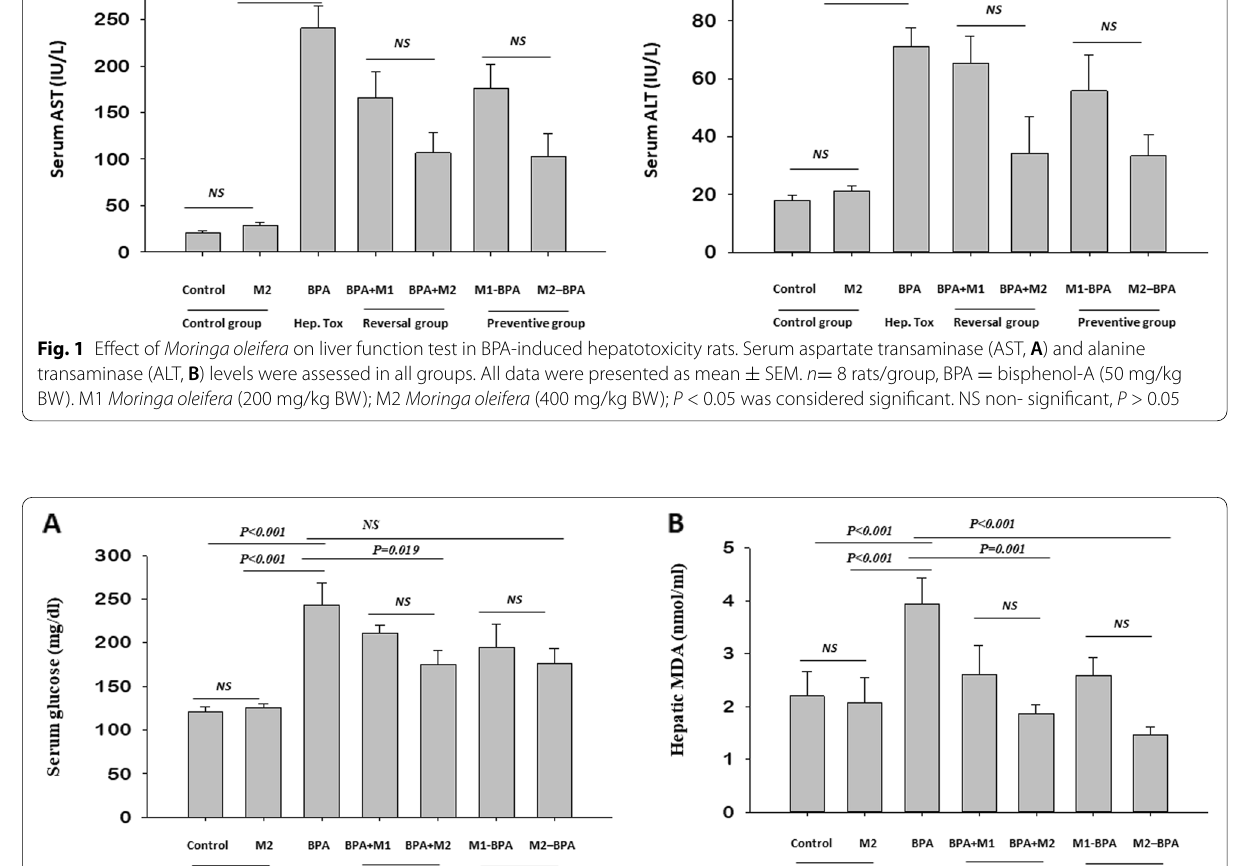
SEM. n 8 rats/group, BPA ± =